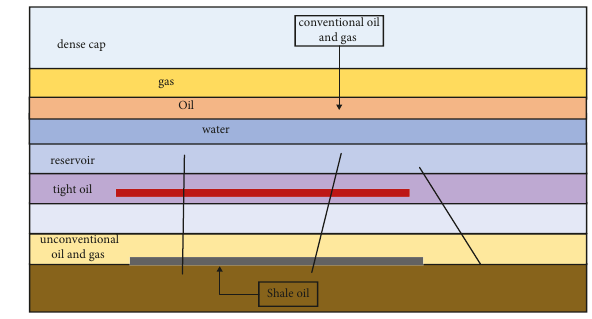
Figure 5: Formation process of tight